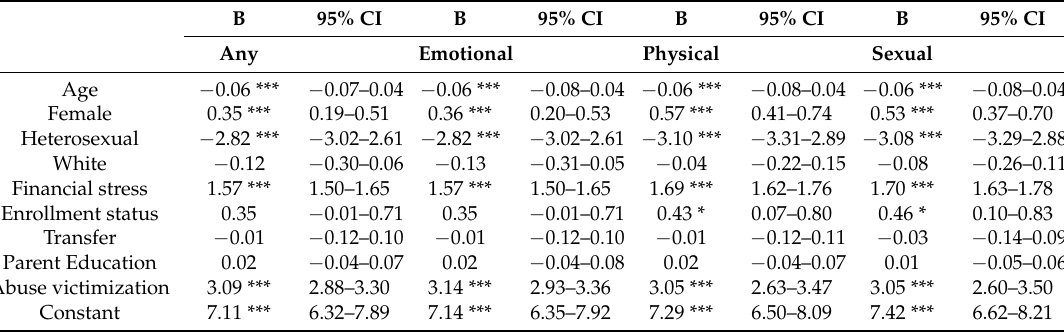
Table 3. Summary of linear regressions for the association between violence victimization and depressive symptoms.